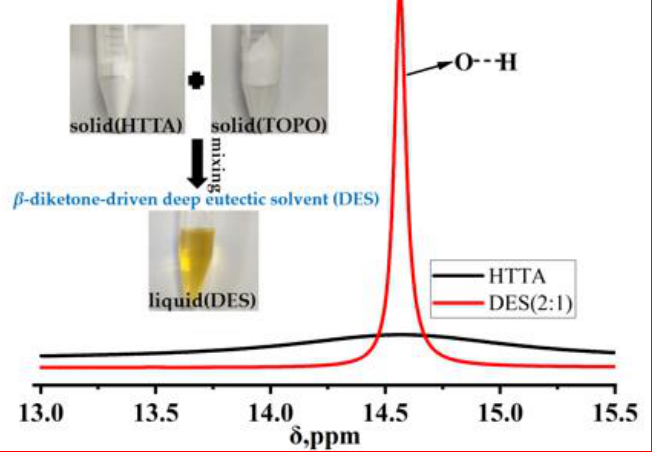
Figure 3. 1 H NMR spectra of the HTTA extractant and DES extractant (molar ratio: HTTA/TOPO = 2/1).